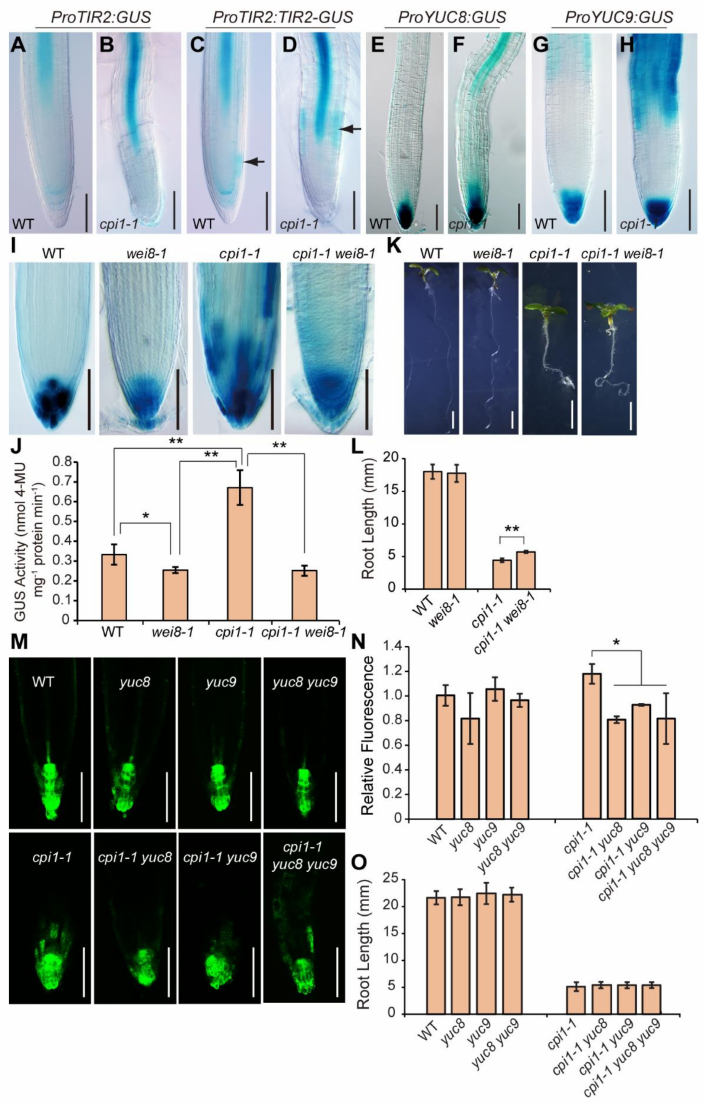
Figure 3. Auxin biosynthesis gene promoter activity is enhanced in cpi1-1 and the cpi1-1 short root phenotype is partially suppressed by the wei8-1 mutation. ( A – H ) Expression patterns of ProTIR2:GUS , ProTIR2:TIR2-GUS , ProYUC8:GUS , and ProYUC9:GUS in 5-day-old WT and cpi1-1 seedling roots. Shown are representative images of n = 3 independent experiments (employing 6 to 30 seedlings per experiment). The arrow in ( C ) indicates GUS staining in the root proximal meristem; The arrow in ( D ) indicates GUS staining in the elongation zone; ( I ) Expression patterns of DR5:GUS in root tips of 5-day-old WT, wei8-1 , cpi1-1 , and cpi1-1 wei8-1 seedlings. Shown are representative images of three independent experiments (employing 18 to 32 seedlings per experiment); ( J ) Quantitative DR5:GUS activity assay in 5-day-old seedlings. The presented data are means ± SD of n = 3 independent experiments. * p < 0.05, ** p < 0.01 (one-way ANOVA with Tukey’s test); ( K , L ) Phenotypes ( K ) and root length ( L ) of 7-day-old seedlings. The presented data are means ± SD of n = 3 experiments (employing 13 to 28 seedlings per experiment). ** p < 0.01 (Student’s t -test, one-tailed, two-sample equal variance); ( M , N ) Expression patterns of DR5 rev :GFP in root tips ( M ) and quantification of GFP fluorescence ( N ). The presented data are means ± SD of n = 3 independent experiments (employing 6 to 11 roots per experiment). * p < 0.05 (one-way ANOVA with Tukey’s test); ( O ) Root length of 7-day-old seedlings. The presented data are means ± SD of n = 3 independent experiments (employing 9 to 28 seedlings per experiment). No significant difference between cpi1-1 single and cpi1-1 yuc8 and cpi1-1 yuc9 double and cpi1-1 yuc8 yuc9 triple mutants by one-way ANOVA ( p < 0.05). Bars = 100 µ m in ( A – I , M ) and 2 mm in ( K